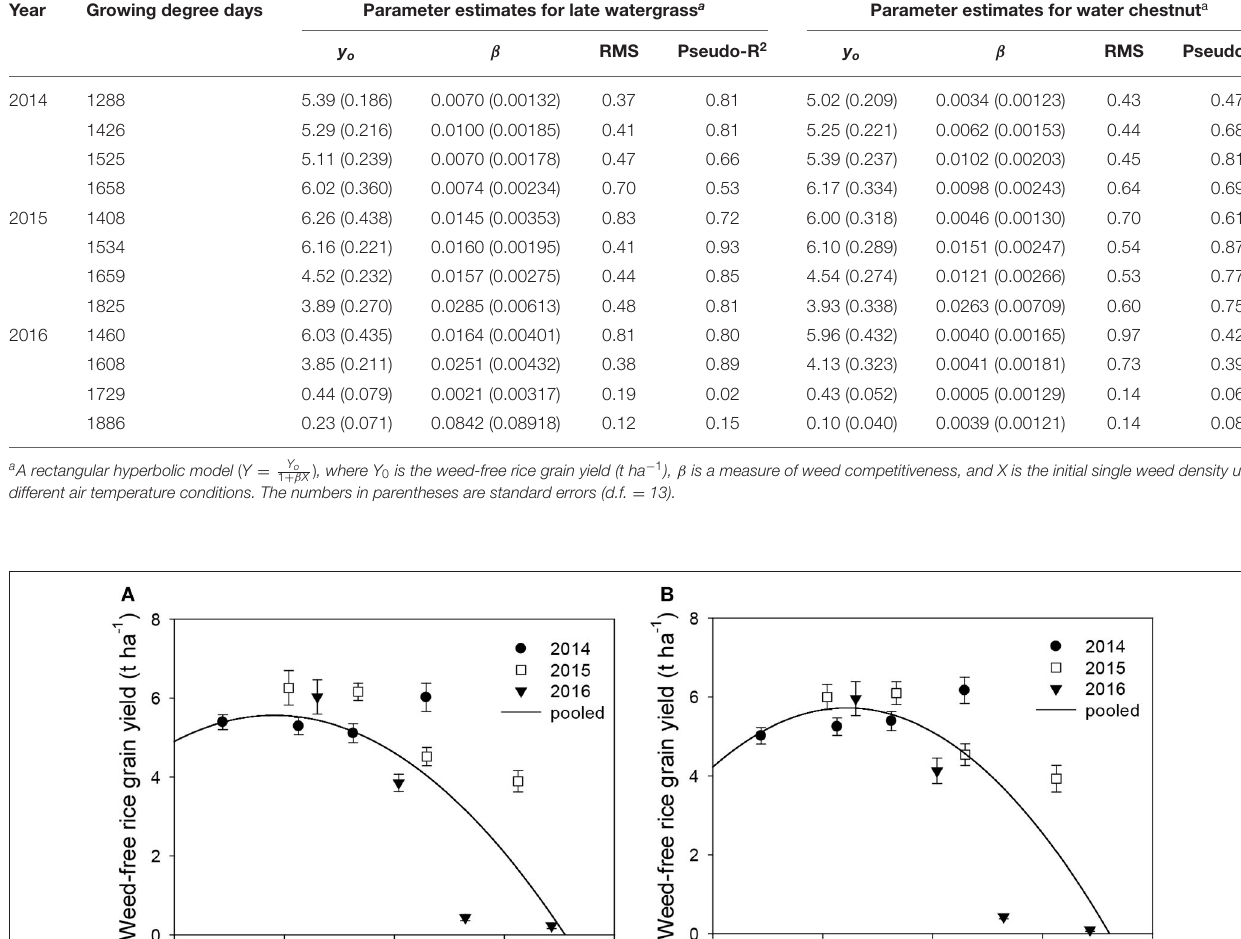
affected by GDD, respectively, with a small root mean